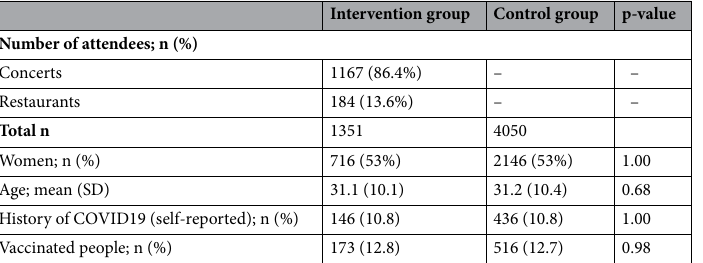
Intervention group Control group